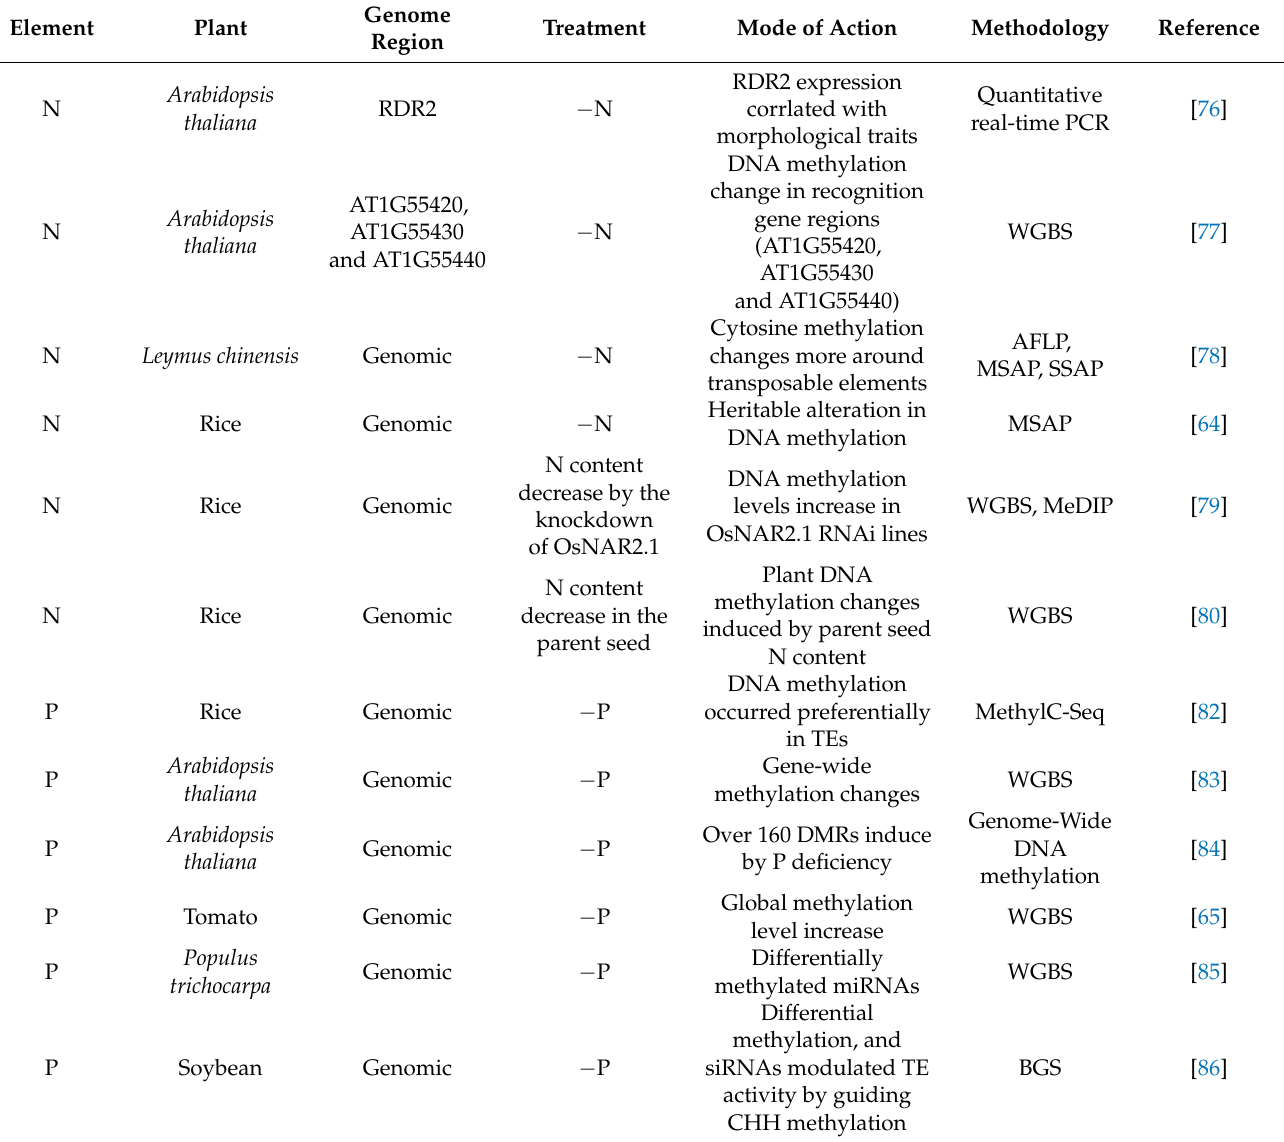
Table 1. Summary of the effects of different nutrient stresses on plant